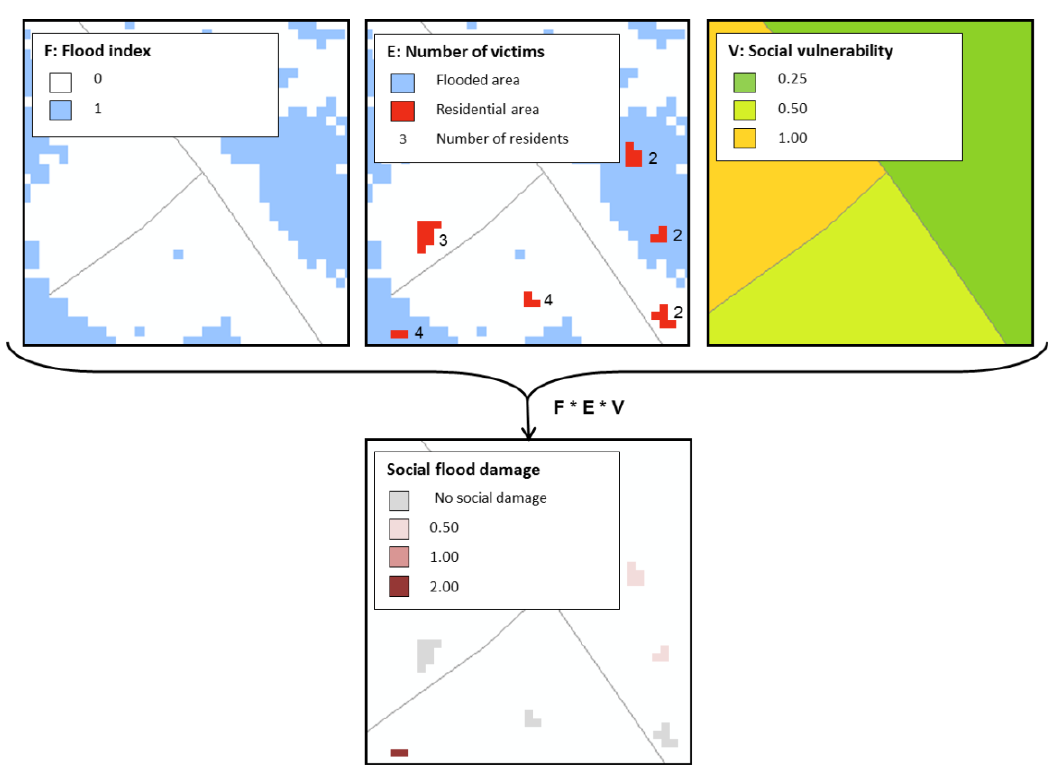
Figure 13. Schematic representation of the calculation of the social damage during floods.